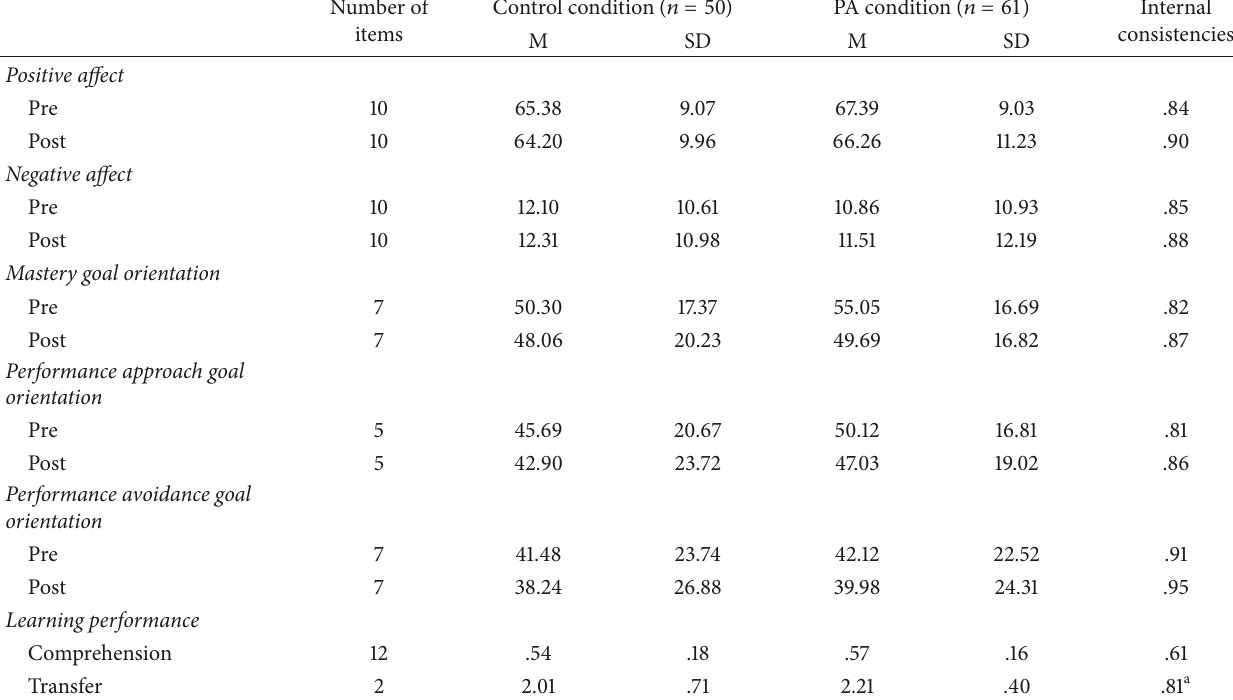
Table 1: Descriptive statistics of affect and performance (𝑁 = 111)